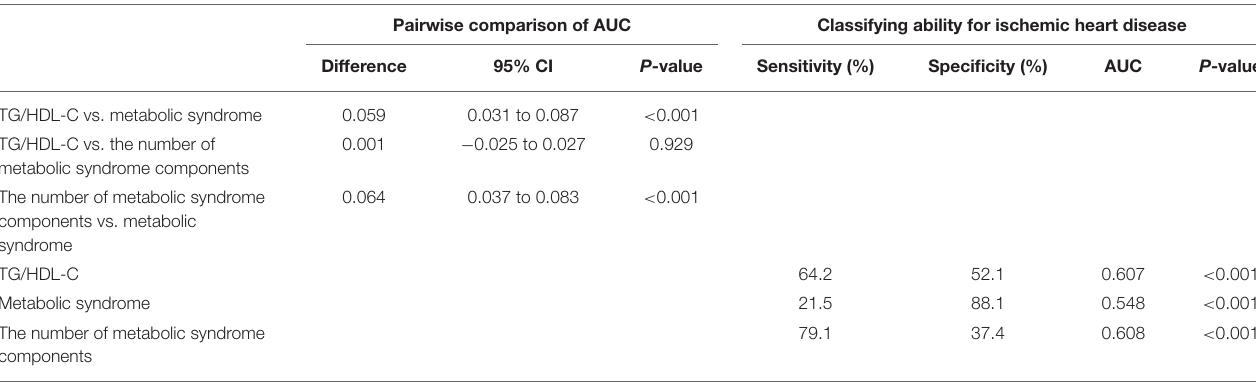
TABLE 5 | TG/HDL-C vs. metabolic syndrome and the number of metabolic syndrome components for predicting ischemic heart disease. Pairwise comparison of AUC Classifying ability for ischemic heart disease Difference 95% CI P -value Sensitivity (%) Specificity (%) AUC P -value TG/HDL-C vs. metabolic syndrome 0.059 0.031 to 0.087 <